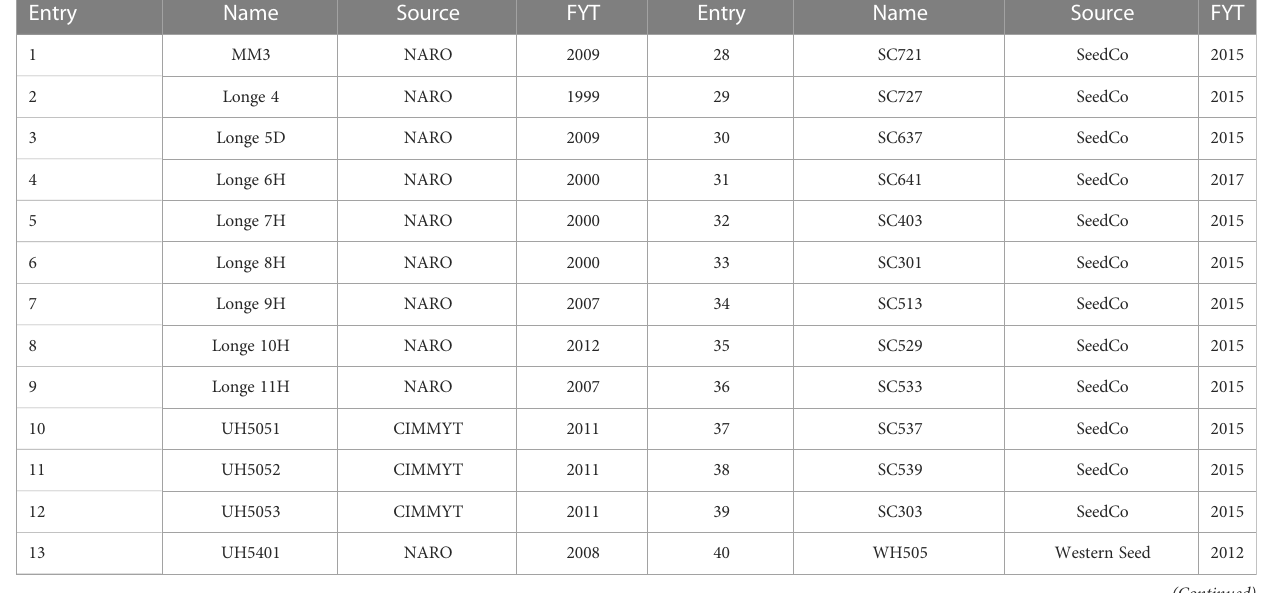
TABLE 3 List of entries in the Era trial conducted at six locations in Uganda in